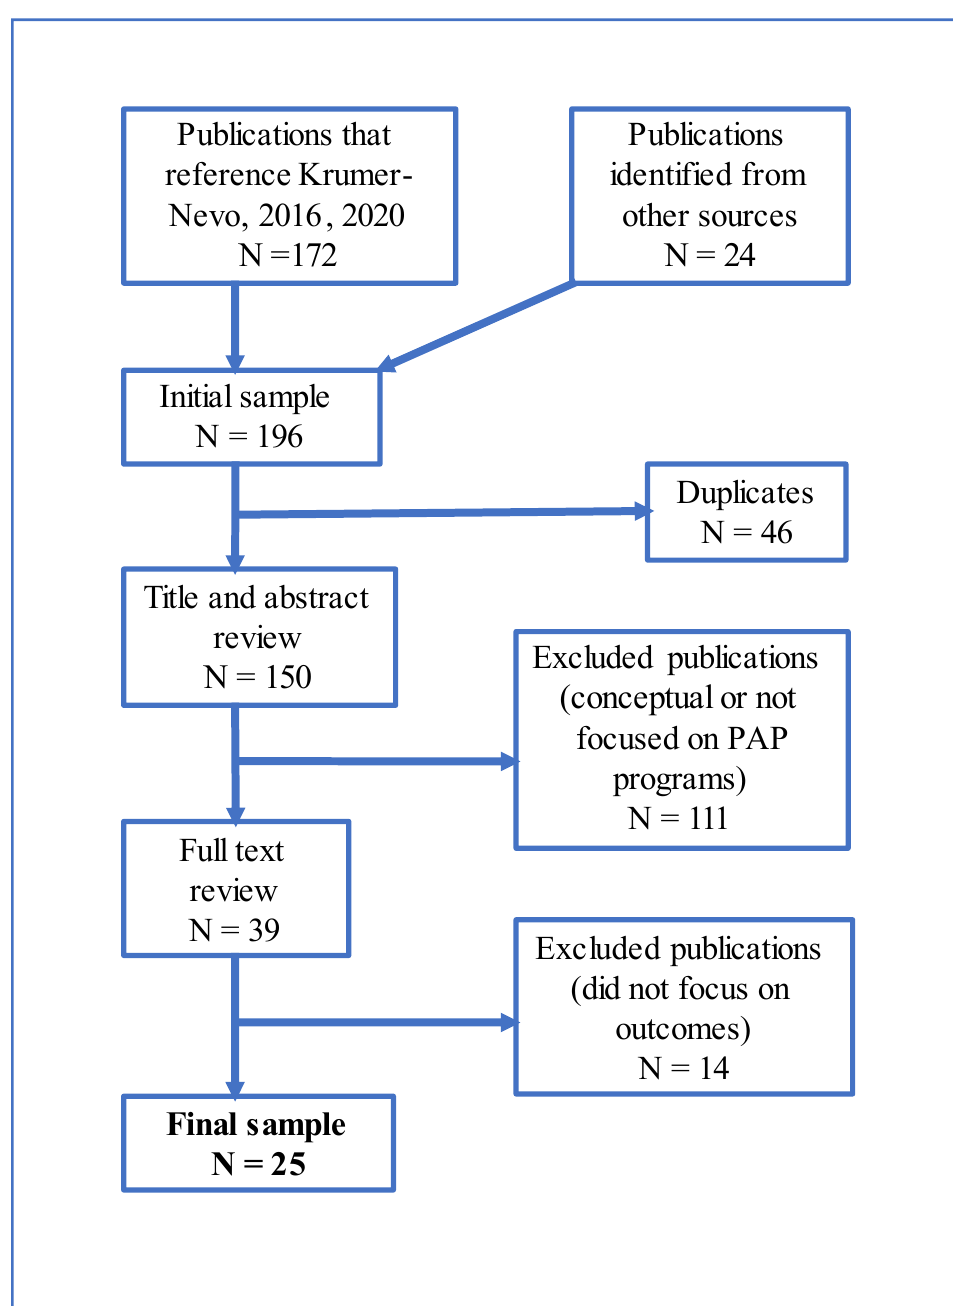
Figure 1. Screening Figure